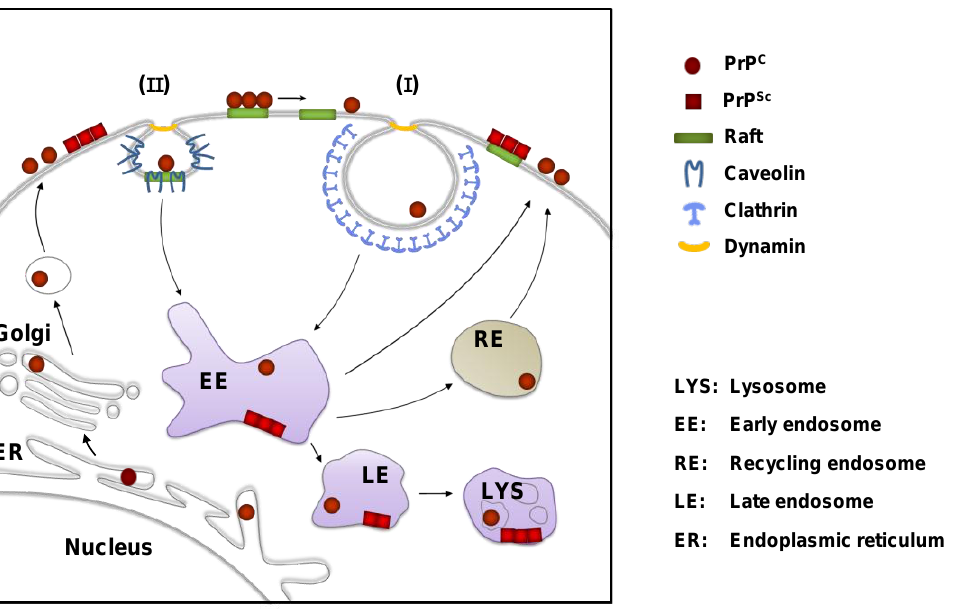
Figure 2. Cell biology of PrP in scrapie-infected cells. PrP C is synthesized in the endoplasmic reticulum (ER) and passes through the secretory pathway to the cell surface, where it resides in lipid rafts. In many cells, PrP C leaves lipid rafts prior to being internalized by clathrin-dependent endocytosis (I). Clathrin-independent raft/caveolae-dependent internalization (II) of PrP C has also been proposed for some cells. PrP C can be degraded by lysosomes or rapidly recycled back to the cell surface by recycling endosomes (RE). In cultured scrapie-infected cells the conversion of PrP C to PrP Sc is believed to take place on the cell surface and/or in vesicles along the endolysosomal pathway. After conversion PrP Sc can accumulate at the cell surface or in intracellular vesicles (e.g.